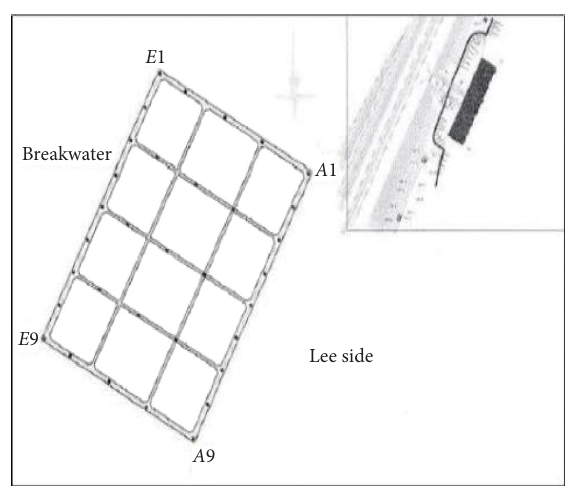
Figure 29: Caisson plan location of monitoring points. Table 4: Energy results per unit volume for compaction in laboratory samples and Tombak port